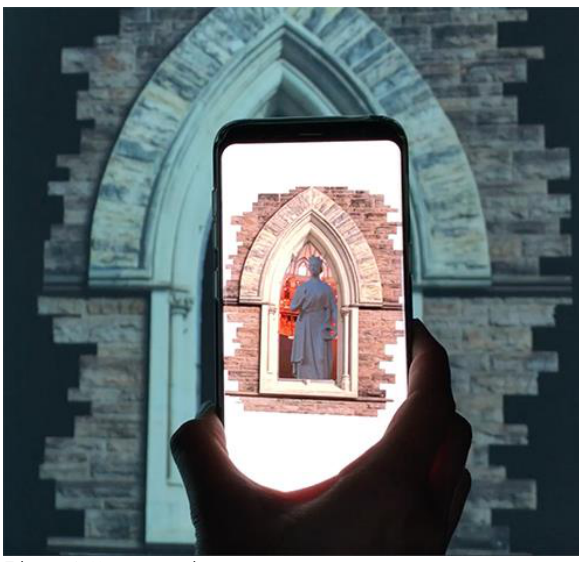
Figure 4. User experience.